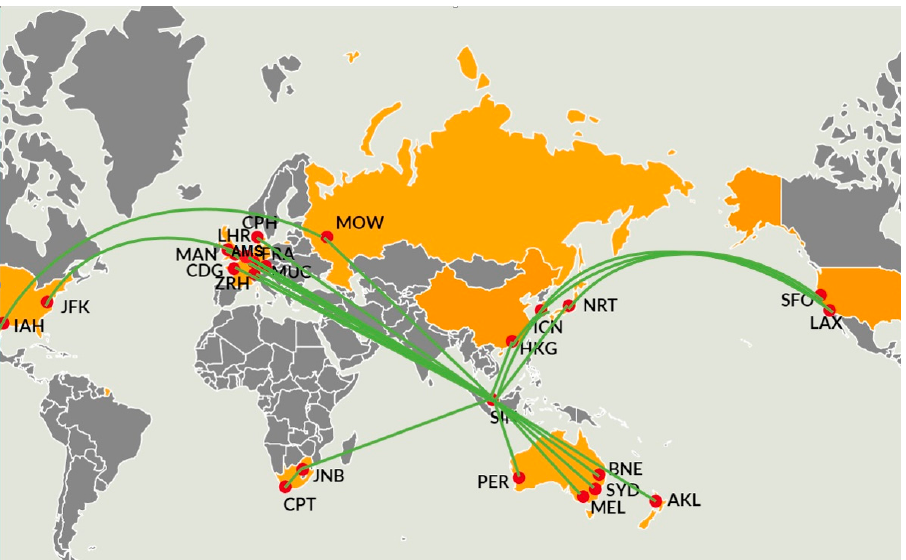
Figure 2. Singapore Airlines 2015 long-haul network. Legend: AKL = Auckland, AMS = Amsterdam, BNE = Brisbane, CPH = Copenhagen, CPT = Cape Town, HKG = Hong Kong, IAH = Houston, ICN = Incheon International Airport, JFK = John F. Kennedy International Airport, JNB = Johannesburg, LAX = Los Angeles International Airport, MAN = Manchester, MEL = Melbourne, MOW = Moscow, NRT = Narita International Airport, PER = Perth, SFO = San Francisco, ZRH = Zurich.